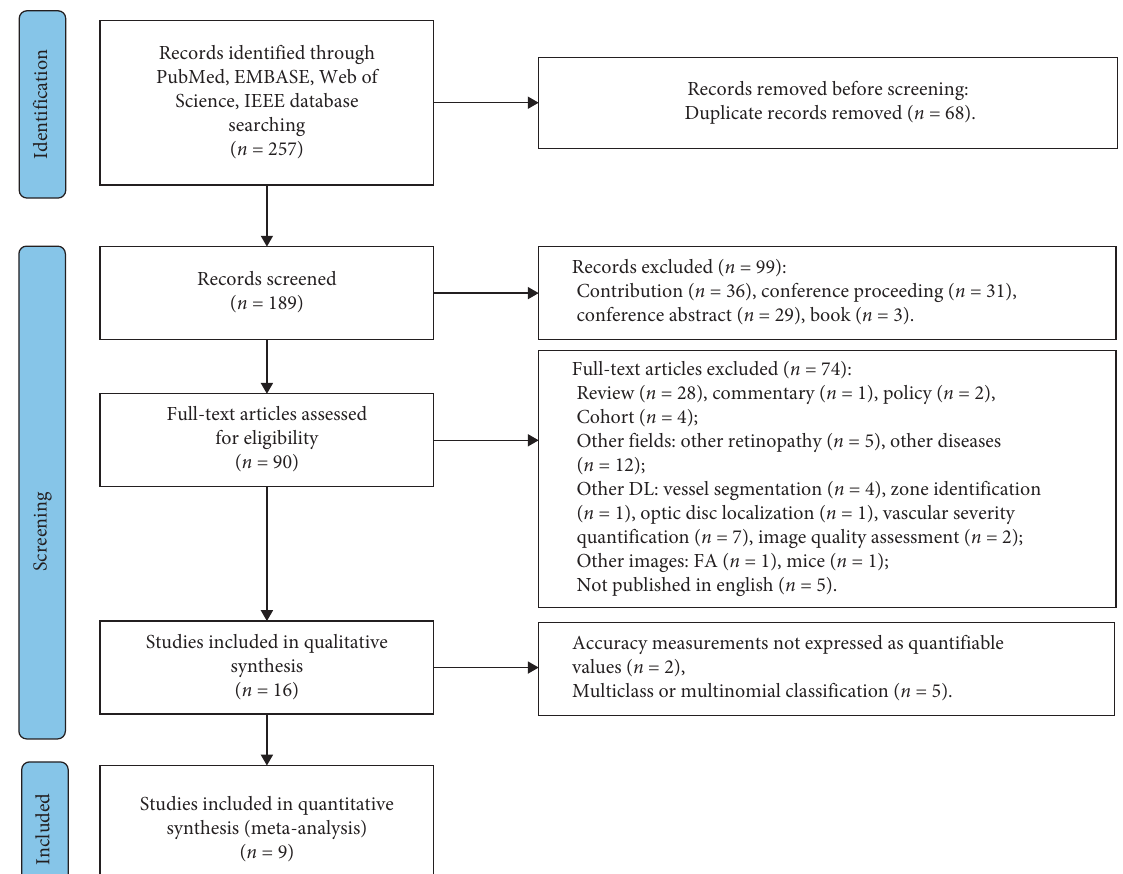
Figure 1: Prisma flow diagram for study